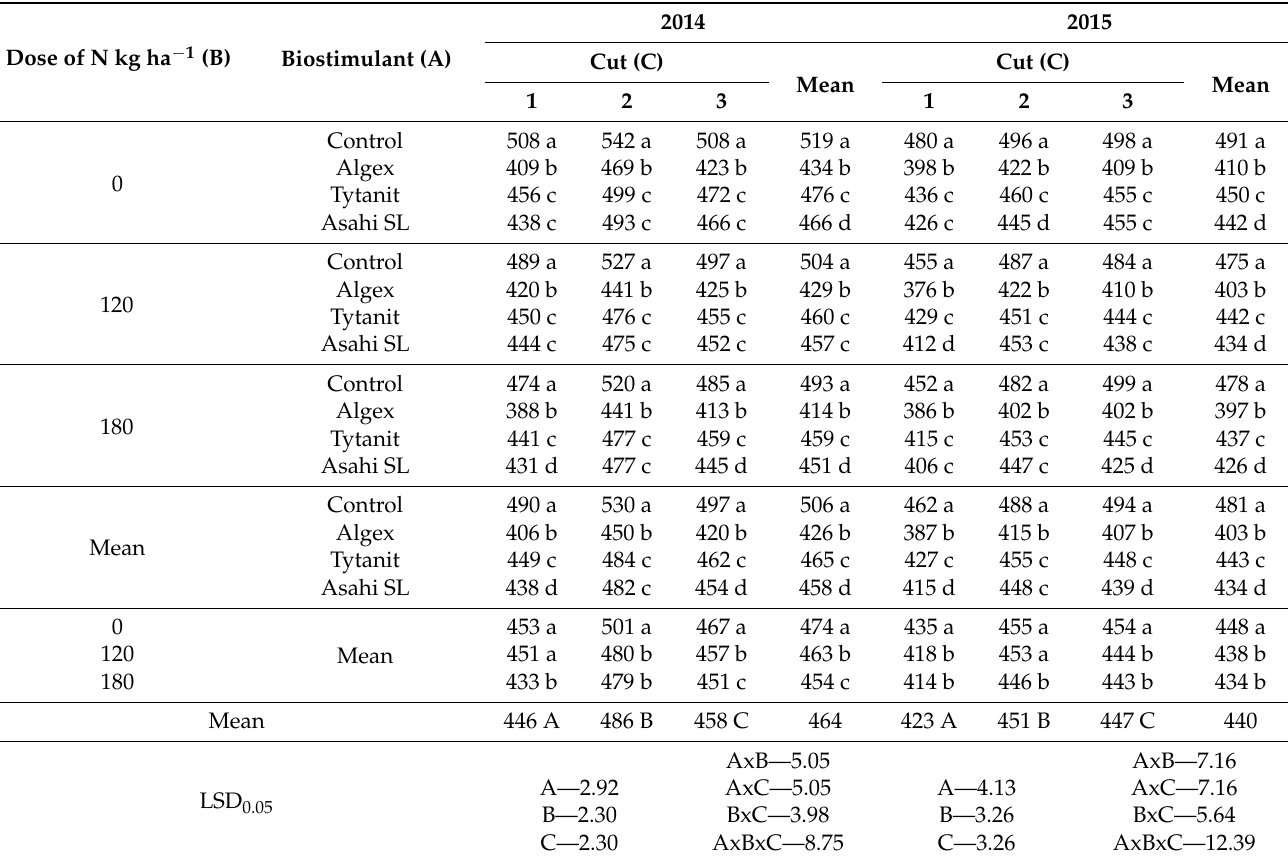
Table 2. The effect of the biostimulants on content of neutral detergent (NDF) in Italian ryegrass by cut and nitrogen fertilization (g kg − 1